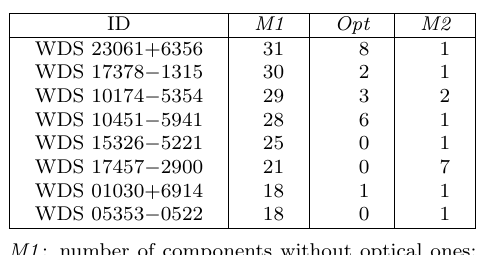
M1 : number of components without optical ones; Opt : number of optical pairs; M2 : possibly confi- dent hierarchical